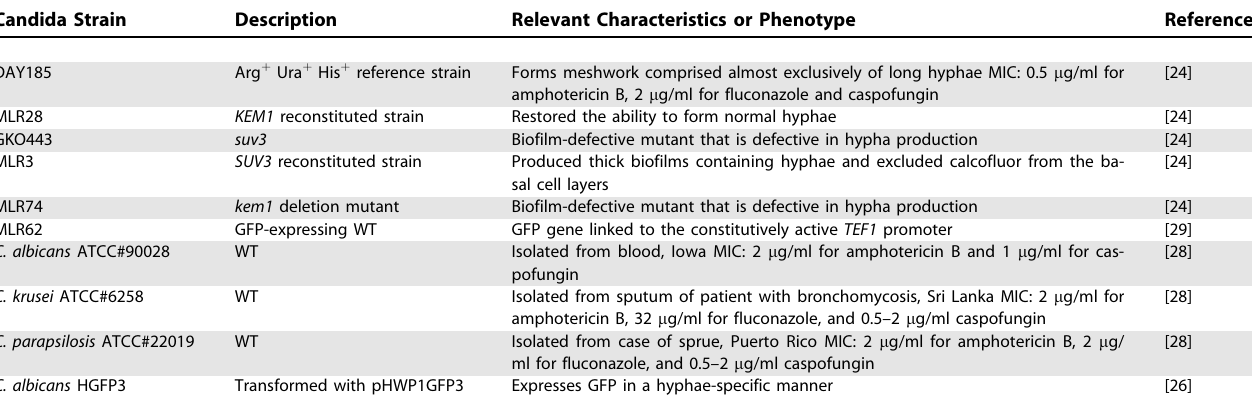
Table 1. C. albicans Strains Used in This Study Candida